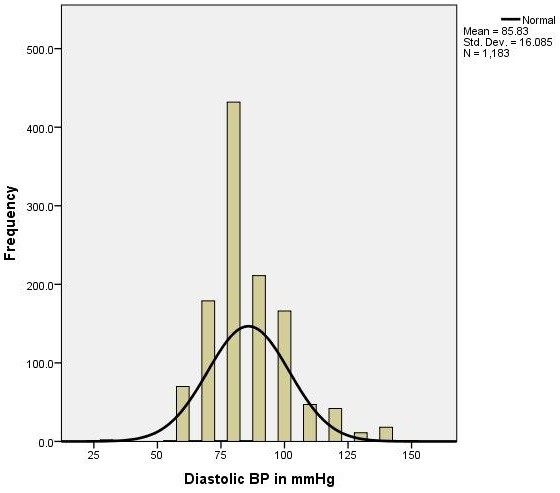
Graphic (histogram) distribution of diastolic blood pressure of study participants (1183) aged ≥ 40 years in Kabul city, 2012.